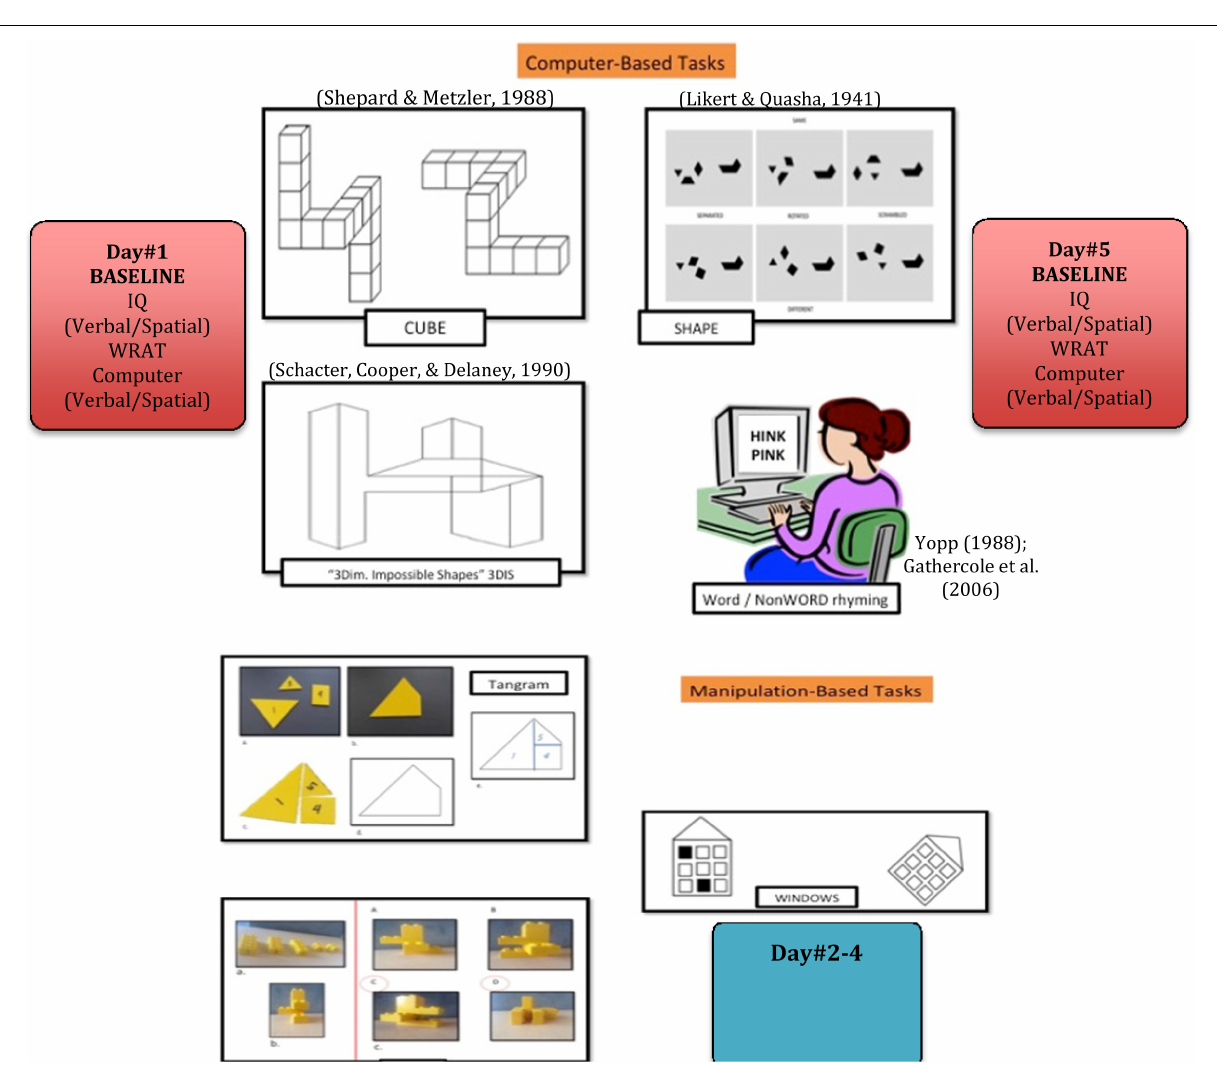
FIGURE 2 | NLB manipulative and computerized